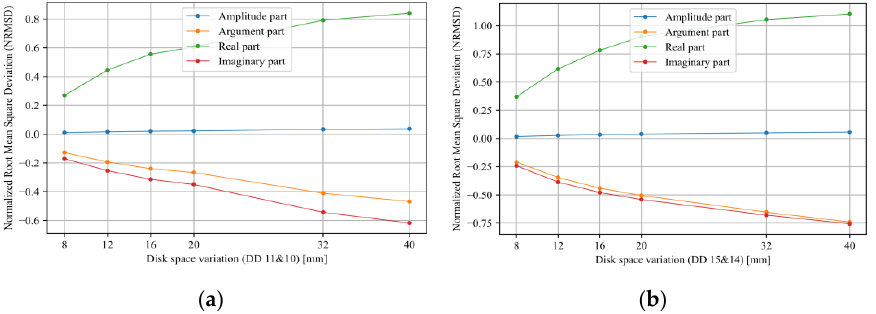
Figure 15. Feature variations based on the severity of the DSV fault in different locations for extracted by the NRMSD index: ( a ) DSV in DD 11 and 10 ( b ) DSV in DD 15 and 14.